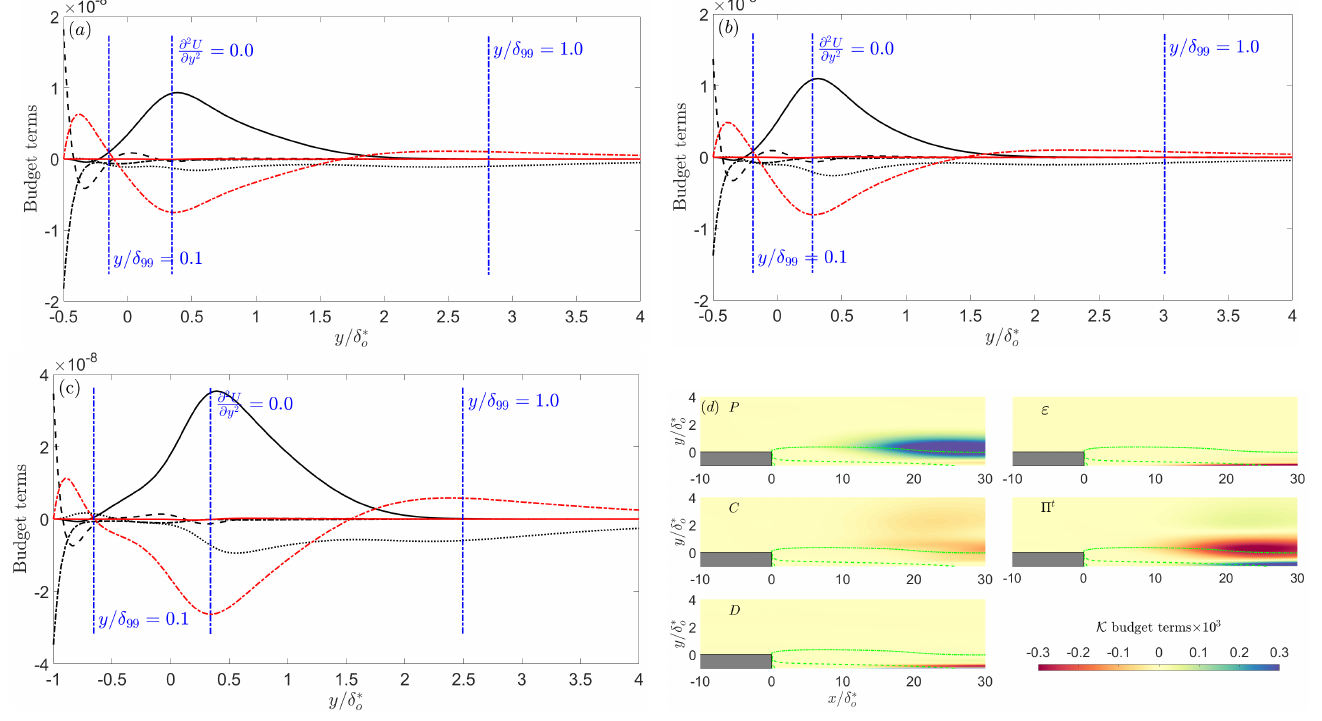
Figure 16. Budget of K at x / δ ∗ o = 10. ( a ) Small step; ( b ) small step, variable U e ; ( c ) large step; ( d ) large step; contours of K budget terms near the